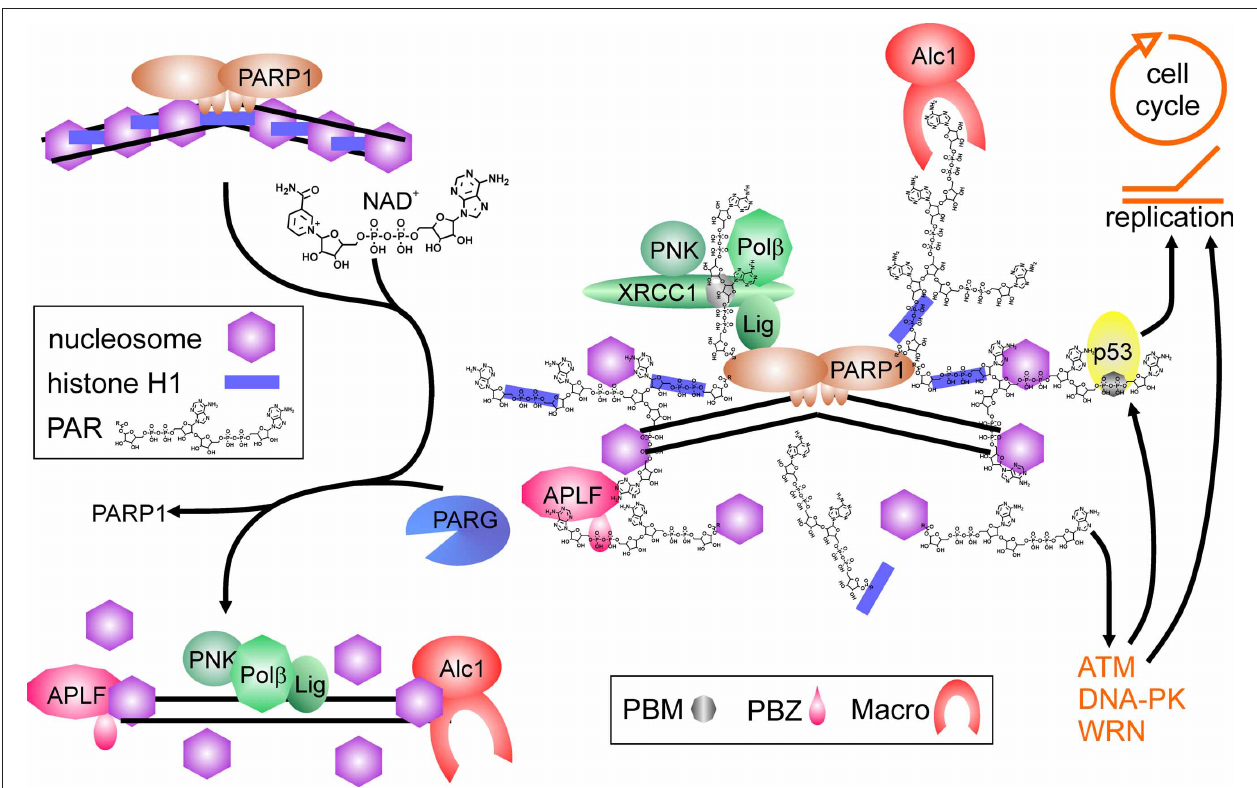
FIGURE 1 | Poly(ADP-ribose) polymerase1 in DNA repair. Binding to DNA breaks and dimerization activates PARP1, which synthesizes poly(ADP-ribose) (PAR) from NAD + , covalently modifying itself and neighboring proteins, i.e., histones (blue bars = histone H1, purple hexagons = core histones). Proteins containing PAR interaction motifs (PBM = PAR binding motif, PBZ = PAR binding zinc finger; Macro = macro-domain) are recruited to the site of damage, whereas histones in the vicinity are displaced from DNA. Auto-modification of PARP1 abrogates PARP1 DNA binding. Recruited